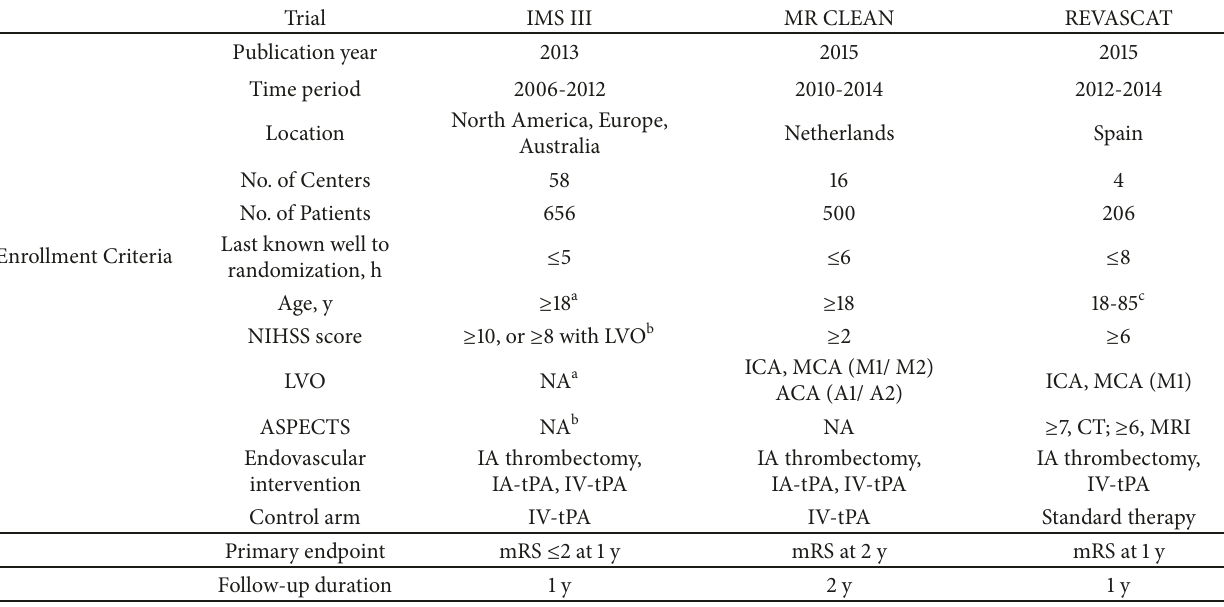
Table 1: Included trials and their respective study designs.